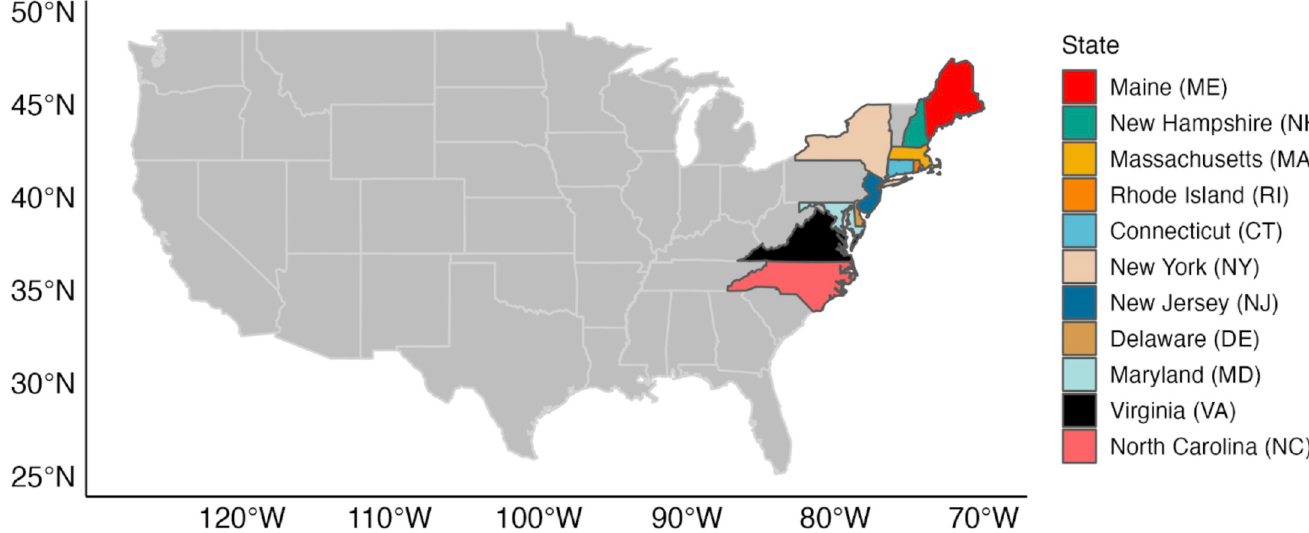
Fig 1. Location of the states included in this study. States presented in legend in latitudinal order.